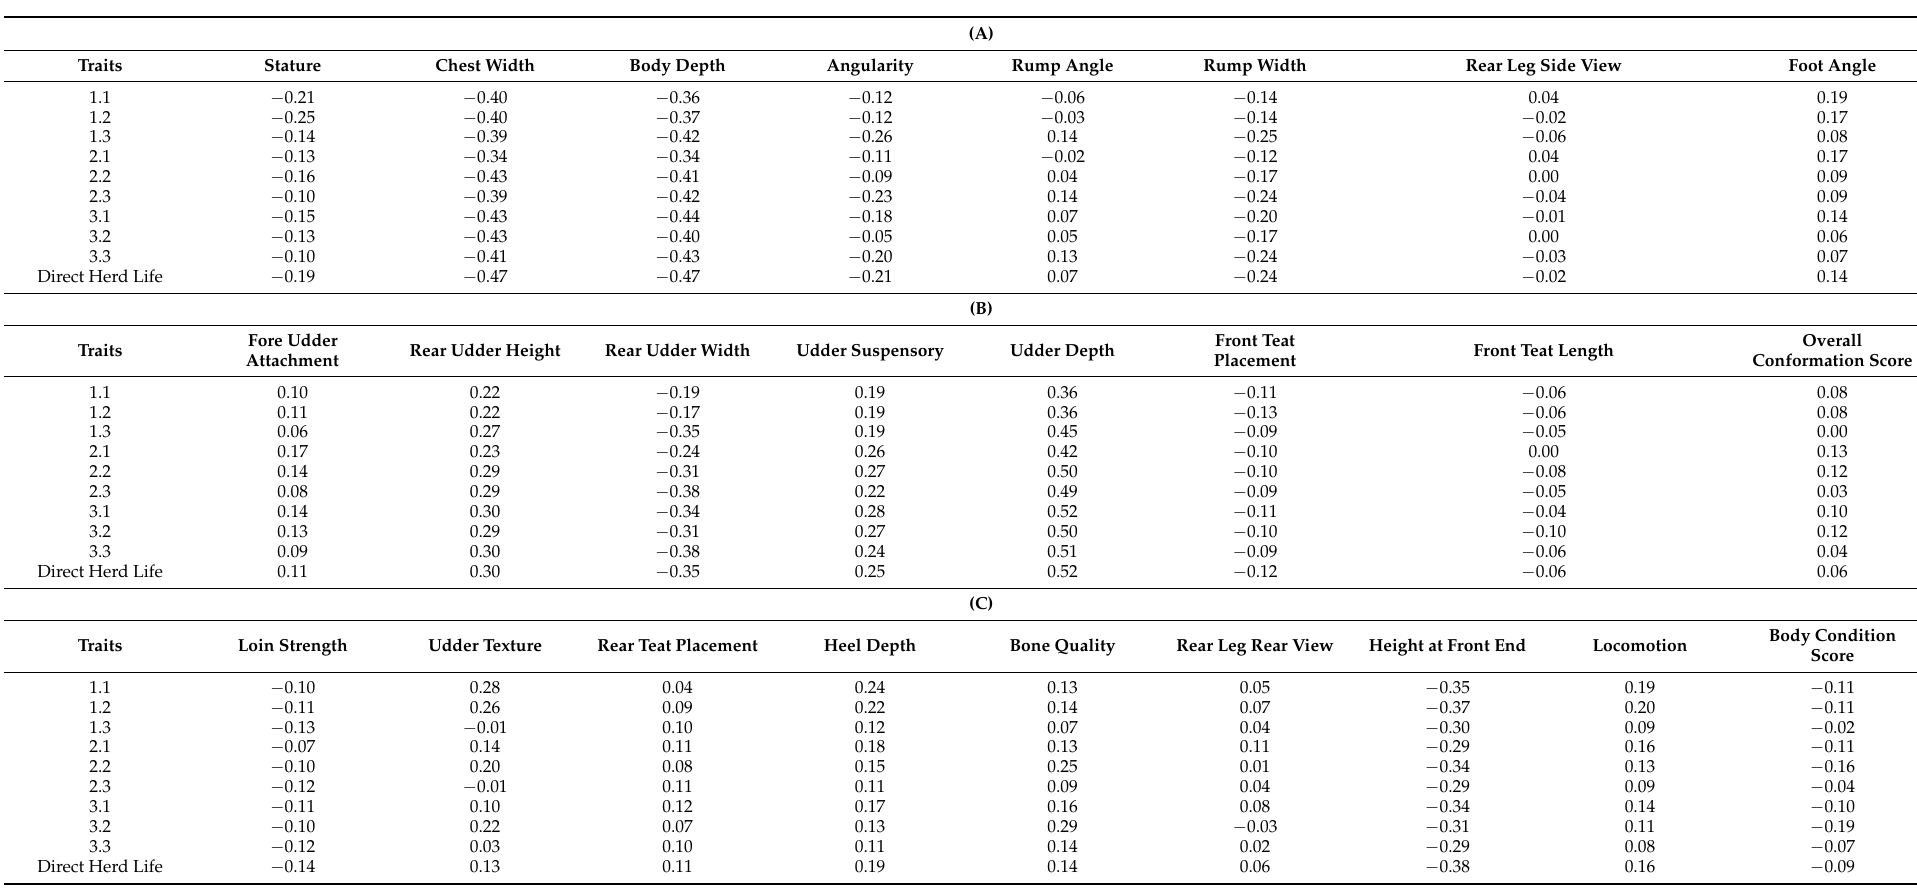
Table 6. ( A ) Breeding value correlations among the conformation traits and sires’ direct herd life for Korean Holstein. ( B ) Breeding value correlations among the conformation traits and sires’ direct herd life for Korean Holstein. ( C ) Breeding value correlations among the conformation traits and sires’ direct herd life for Korean